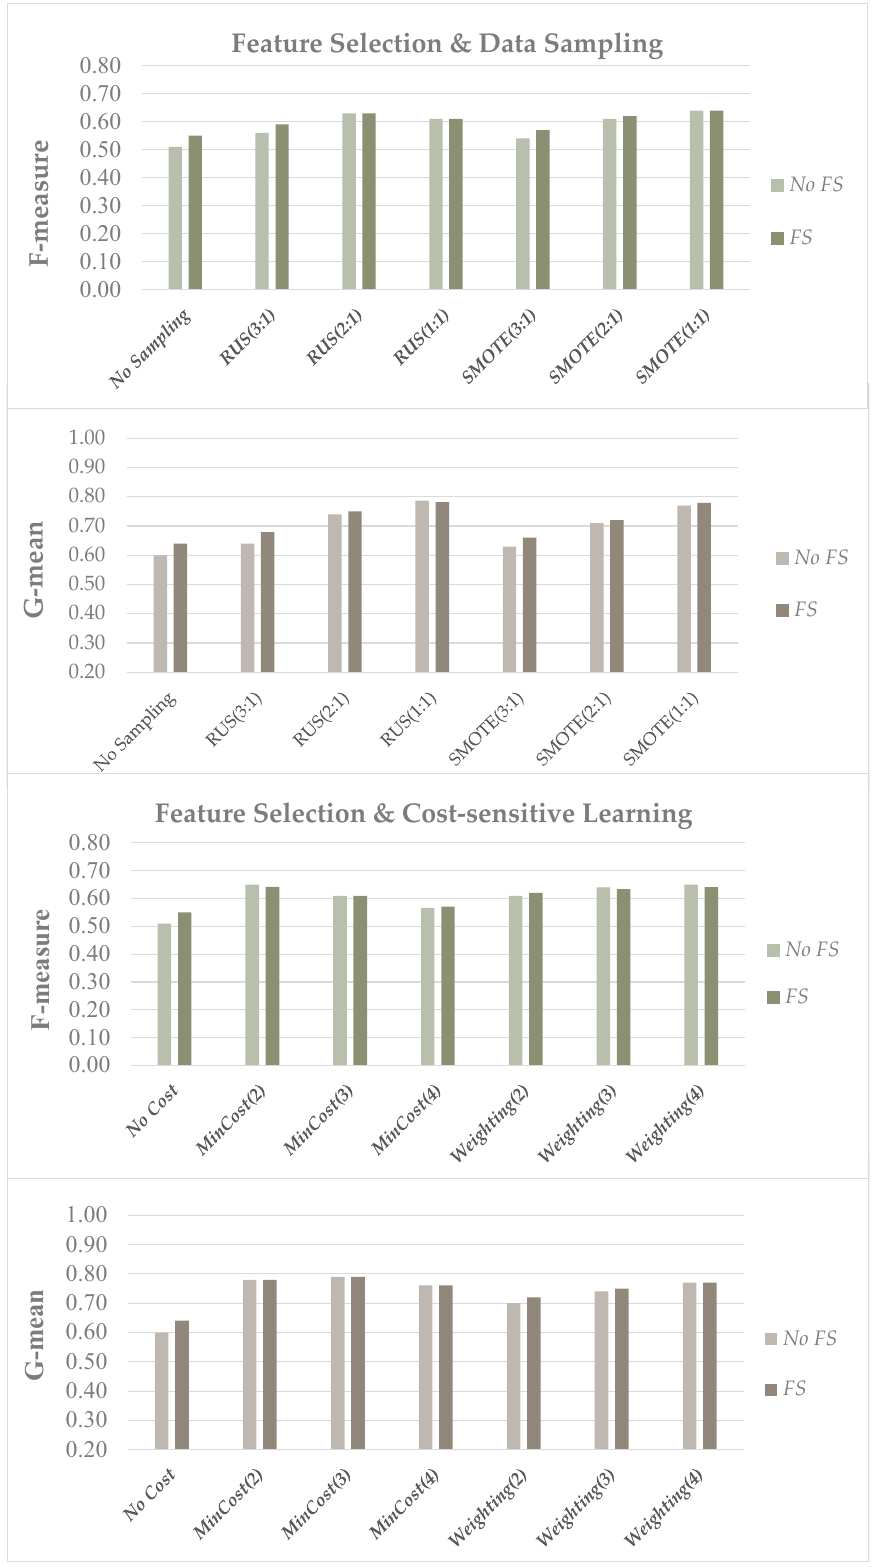
Figure 4. Mountain dataset: F-measure and G-mean performance of the RF classifier in conjunction with feature selection (CFS filter) and imbalance learning methods (data sampling and cost-sensitive learning).